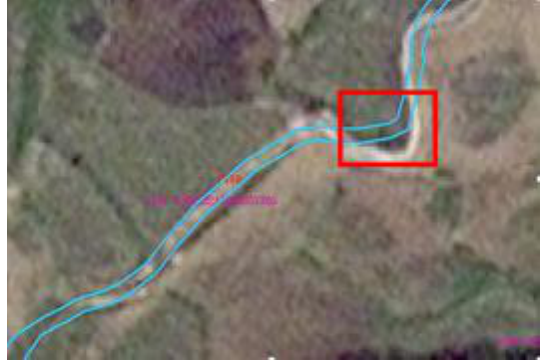
Figure 4. inconsistency between road patch and image texture